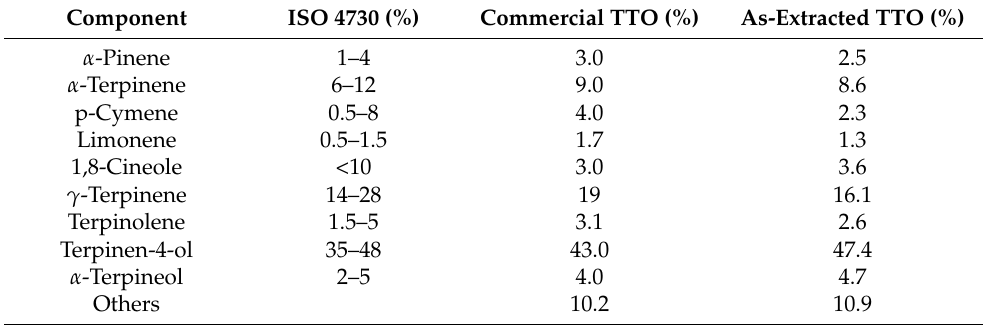
Table 1. Compositions of the in-house hydrodistilled and commercial tea tree oil (TTO) by GC-FID (according to ISO 4730:2017 but with n -decane as an internal